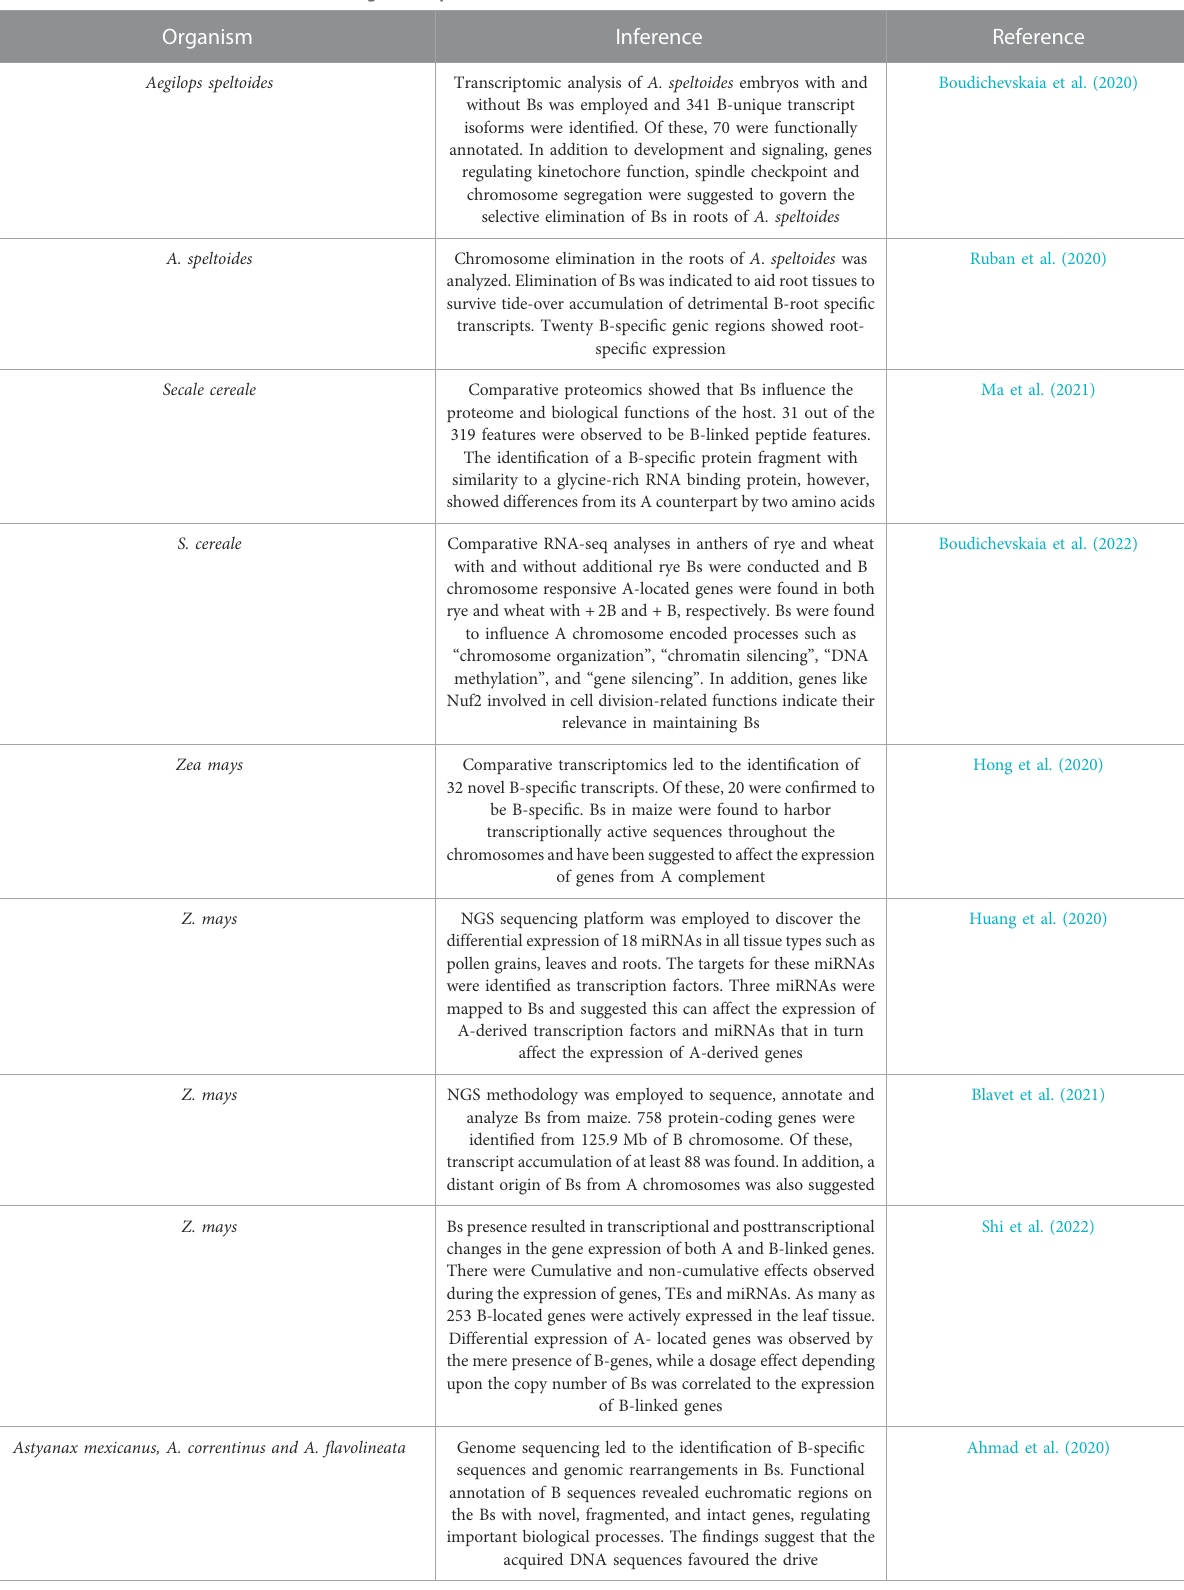
TABLE 2 Functional characterization of B-linked genes in plants and animals a